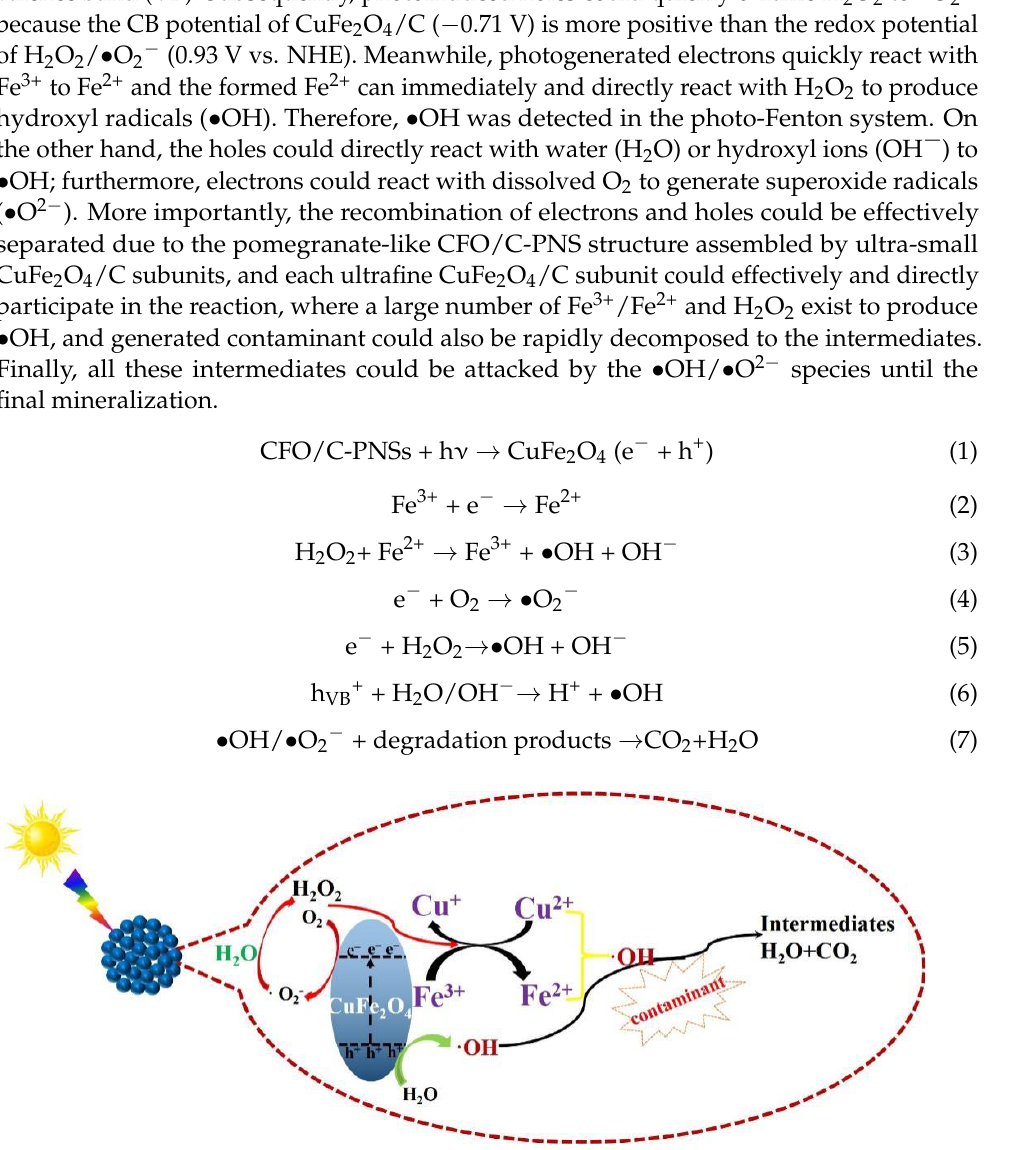
Figure 12. Schematic diagram of possible mechanism of photo-Fenton-like catalytic reaction of CFO/C-PNSs.